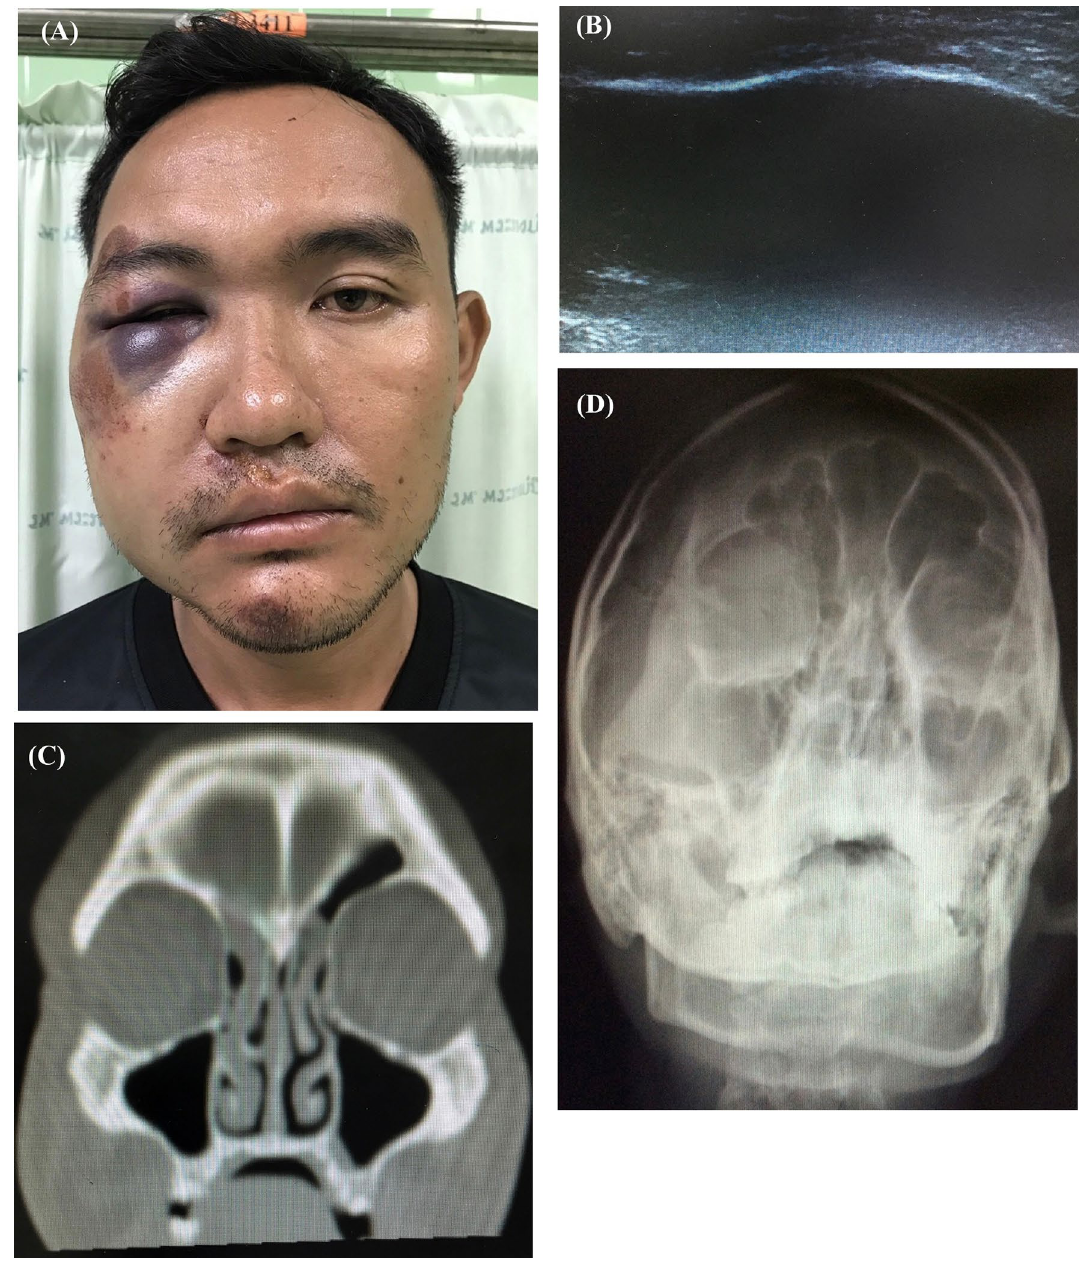
Fig. 4 a – d Case of 33-year-old male: history of vehicle accident, presented with marked swelling of right periorbital area, no fracture of infra orbital rim